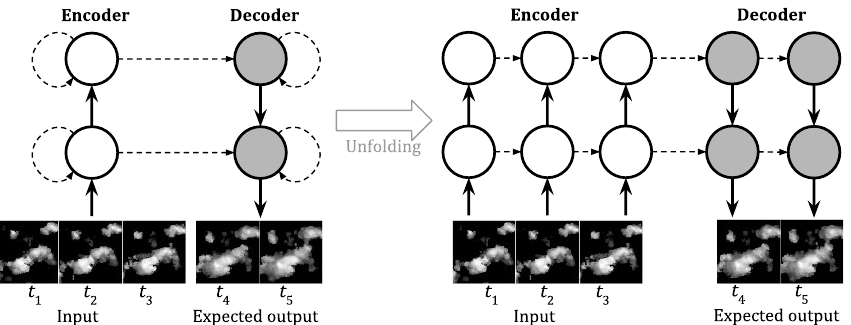
Figure 1. Vanilla sequence-to-sequence structure with two stacked layers for constructing RNN models in precipitation nowcasting (adapted from [6]). This design consists of an encoder (white) and a decoder (gray). The circles are RNNs cells and the solid arrows are the cells’ input and output, while the dotted arrows are recurrent operations. In the encoder, the outputs are downsampled by convolutional operations, while, in the decoder, they are upsampled by deconvolutional operations. Thanks to that, models can predict at different spatial